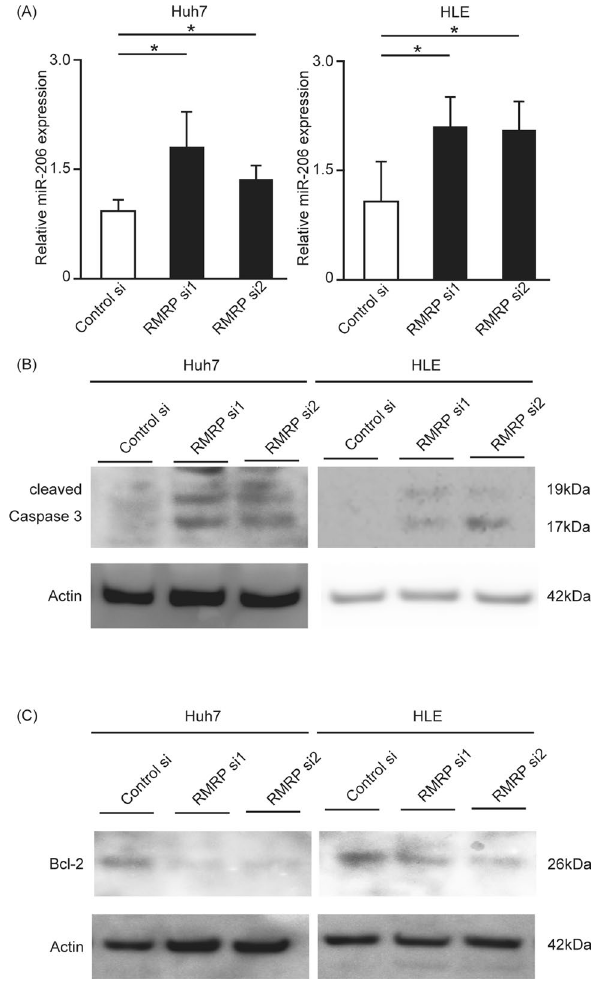
Figure 5. Silencing RMRP leads to an increase in miR-206 and changes cleaved caspase 3 and Bcl-2 expression. Huh7 cells were transfected with control siRNA or RMRP siRNA for 24 h. After transfection, miRNA was extracted, and miR-206 was measured with RT-PCR. miR-206 was increased by RMRP knockdown. Means ± SEM for six replicates are shown. *p < 0.05 compared to the control group by Student’s t-test ( A ). Levels of cleaved caspase 3 ( B ) and Bcl-2 ( C ) were determined with Western blotting. Cleaved caspase 3 was increased and Bcl-2 was decreased by RMRP siRNA. The original gel images of Western blotting are shown in Supplemental Fig.